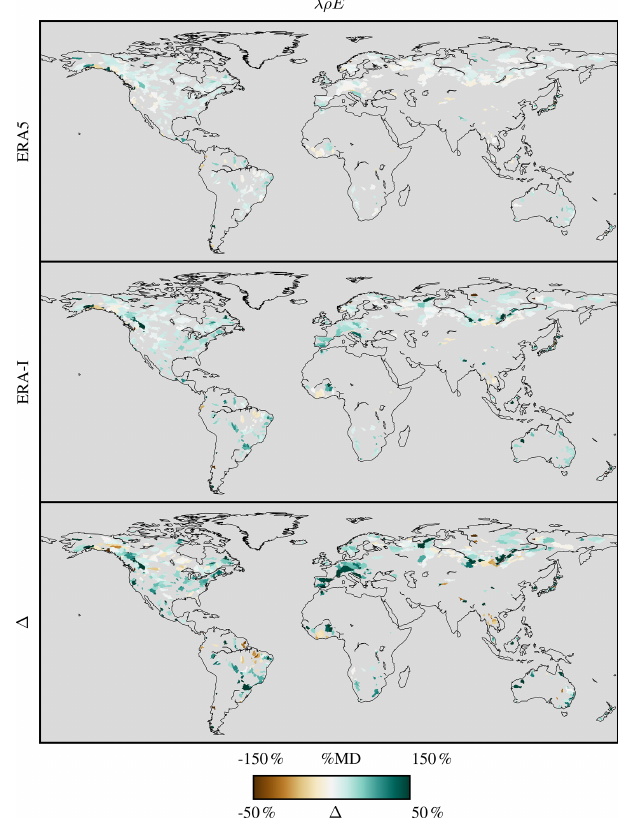
Figure 7. Maps of the bias of the surface latent heat flux ( λρE ) from ERA5 and ERA-I. The bias is calculated against catchment- scale estimates of the fluxes derived using discharge data (Eqs. 1–3) and is assessed by the %MD (raw time series from 707 catchments as reference). The bottom map represents the difference ( (cid:49) ) be- tween the absolute bias in ERA-I and ERA5; hence, green colours represent lower bias in ERA5 than in